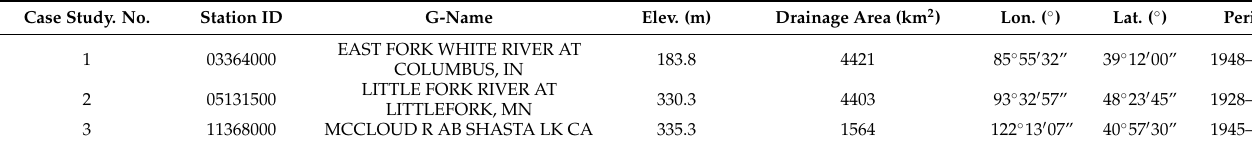
Table 3. Details of the selected case